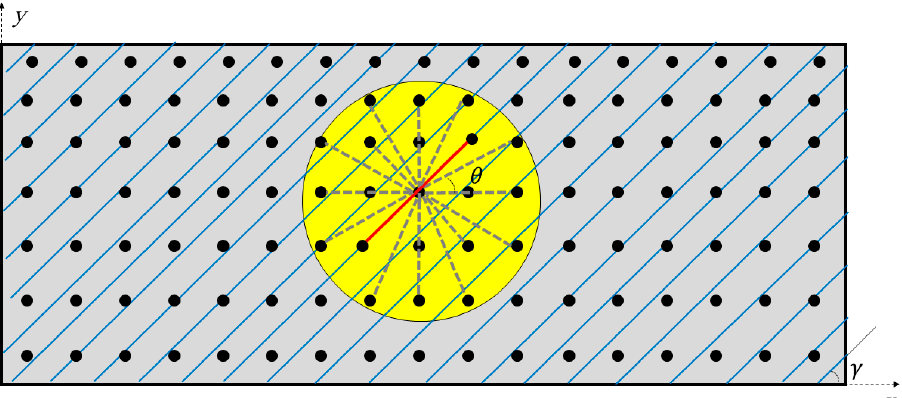
Figure 2. Fiber bond and matrix bond configuration in unidirectional composite.